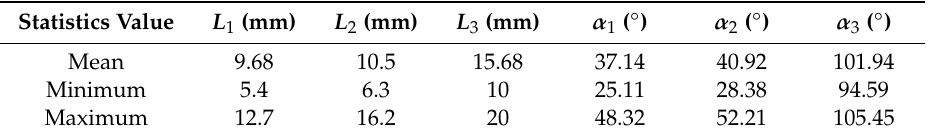
Table 6. Mean, minimum and maximum values of the weld size.